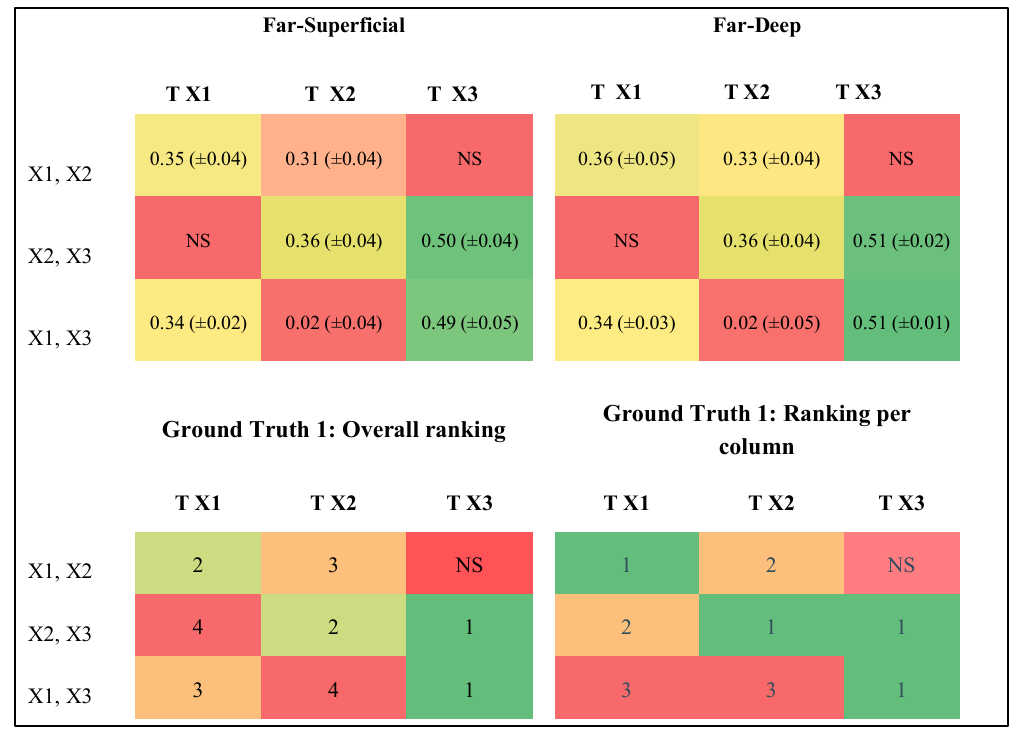
Figure 11. Conv2D, R 2 -strength score for time series pairs (Top) versus ranking of connections in the Ground Truth 1 (Bottom, 1 being the strongest), including self-connectivity. Color coding: dark green > light green > yellow > orange > red. The columns represent the targets, the rows the time series pairs used for predicting the target time series.